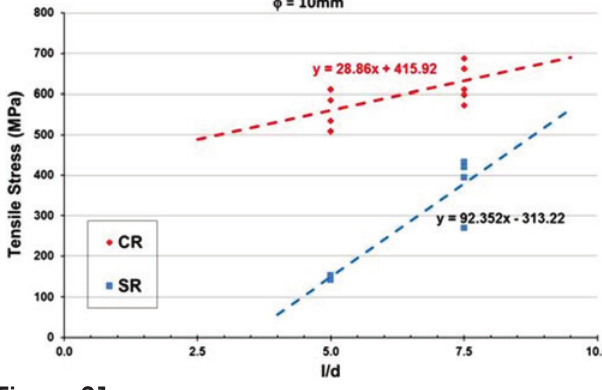
Figure 21 Bar Tensile Stress - l /d relationships,